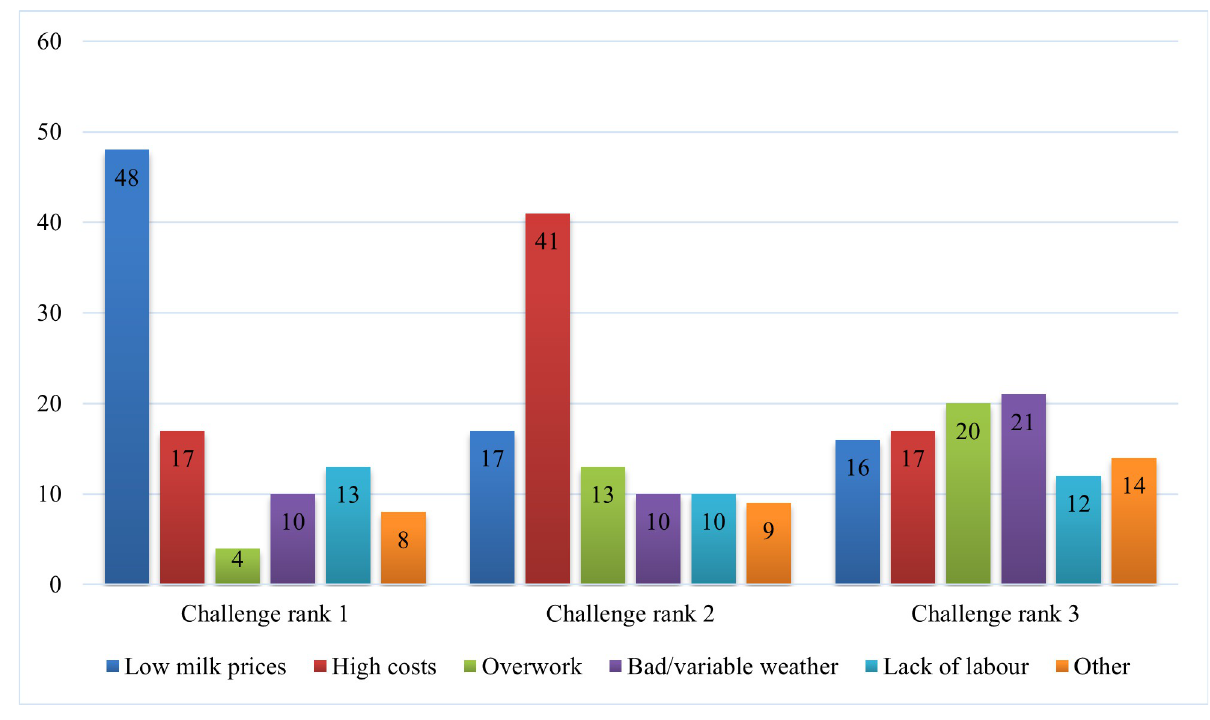
Fig 4. Ranking of challenges facing dairy